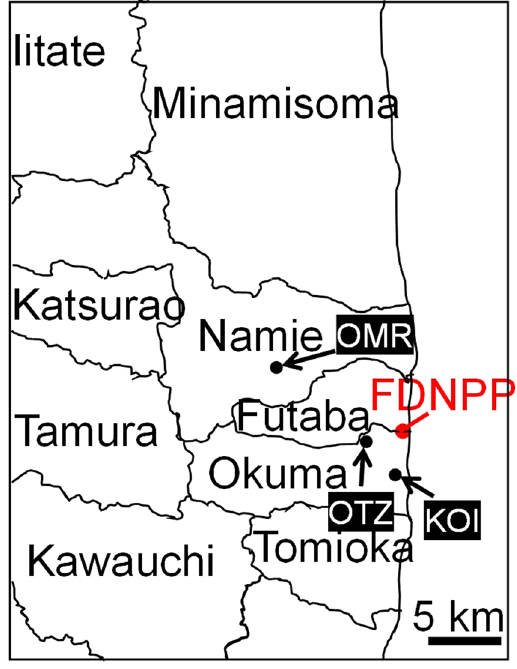
Figure 1. A map showing the location of the samples. This map was produced based on Furuki et al . 16 using the power